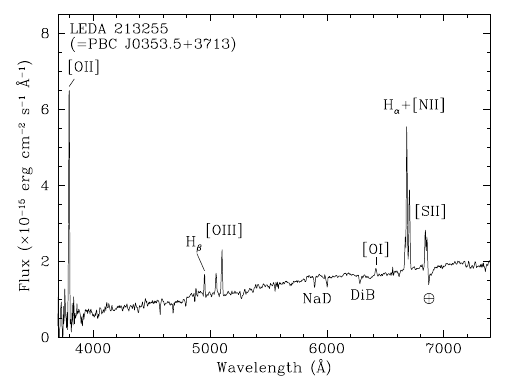
Figure 6: Optical spectrum (not corrected for the in- tervening Galactic absorption) of a typical LINER. The main spectral features are labeled.